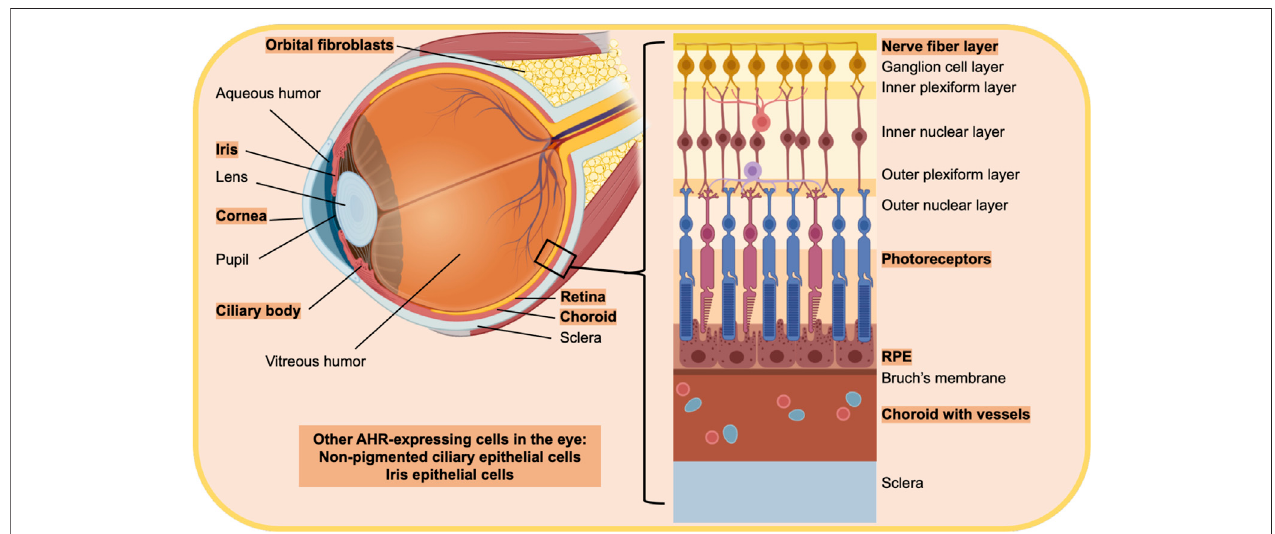
FIGURE 2 | Diagram of the eye highlighting regions and cells that have been shown to express the AHR. The text in orange highlight indicates cells and tissue that expresstheAHR.Theeyeisauniquesensoryorgan,composedofthreemainlayers.Theouterlayeriscomposedofthescleraandcornea,whicharedirectlyexposedto theenvironmentonthesurfaceoftheeye.Themiddlelayerismadeupoftheciliarybody,irisandchoroid whiletheinnermostlayeristheretina.Otherpartsoftheocular systeminclude the fl uid fi lledvitreous inbetweentheretina, andciliarybodyand thelens.Orbital tissue behindtheeye providesstructuralsupportand protects the optic nerve. Retinal pigment epithelial cells (RPE), choroid, the ciliary body and non-pigmented ciliary epithelial cells, orbital fi broblasts and the cornea have all been shown to express the AHR.